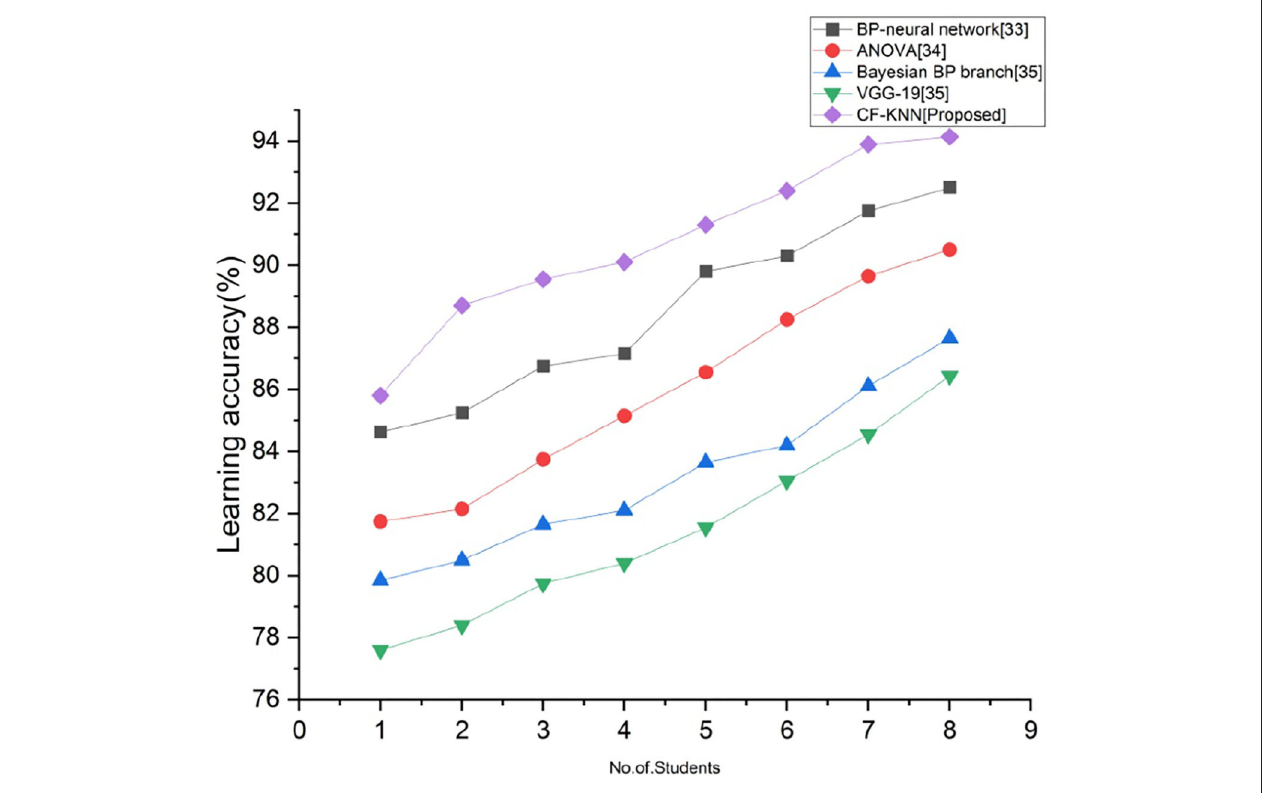
FIGURE 7 | Comparison of learning accuracy with proposed and existing